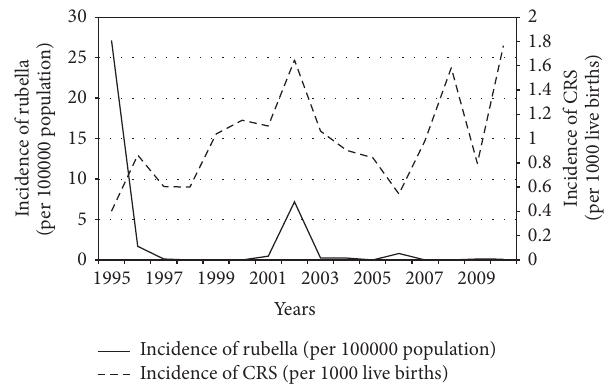
Figure 1: Relationship between incidence of rubella and incidence of congenital rubella syndrome in Fiji,